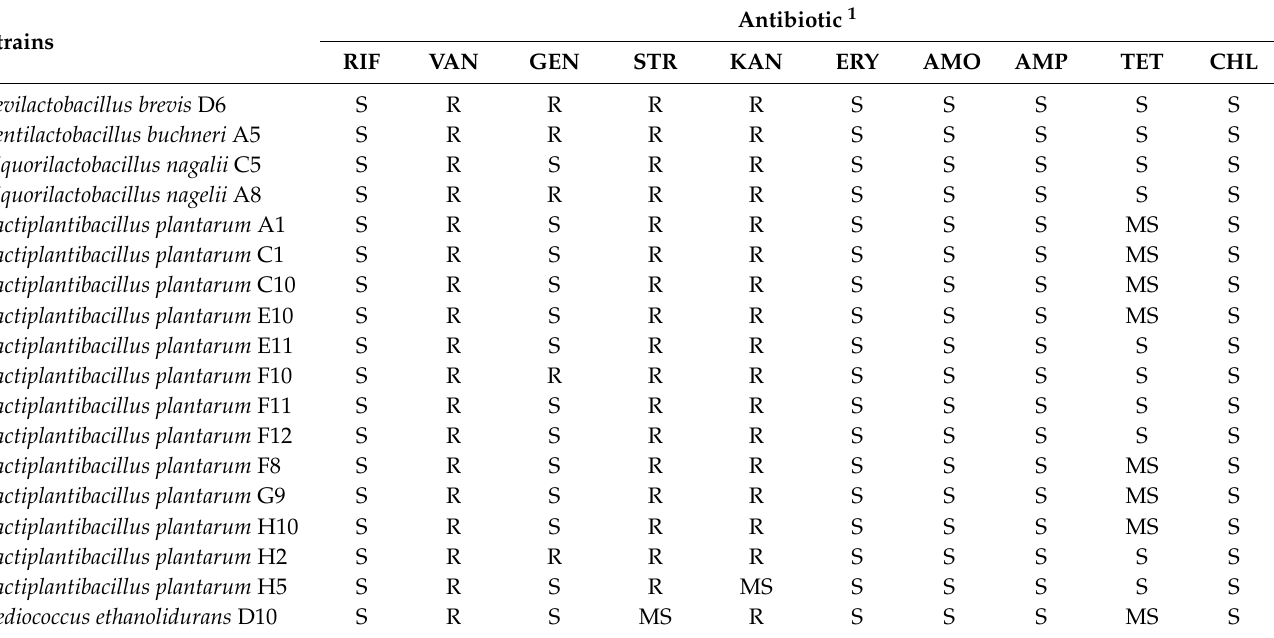
Table 4. Antibiotic susceptibility of the LAB strains.